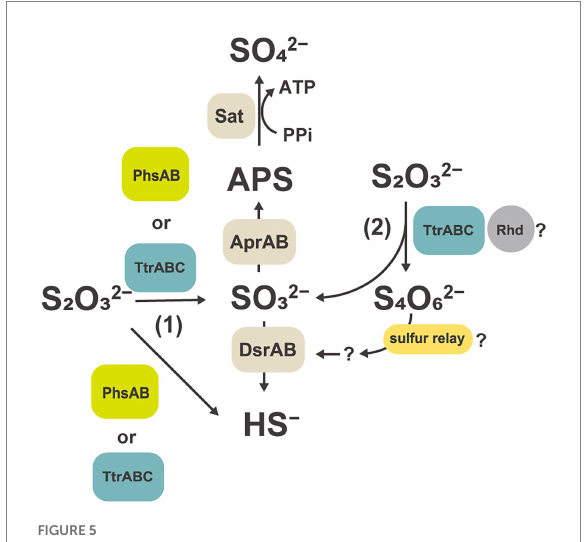
FIGURE 5 Hypothetical thiosulfate disproportionation pathways in strain GF1 T based on a comparative proteomic analysis. Sat, sulfate- adenylyltransferase; Apr, adenylyl-sulfate reductase; APS, adenosine 5 ′ -phosphosulfate; Dsr, dissimilatory sulfite reductase subunit; Phs, thiosulfate reductase-type protein; Ttr, tetrathionate reductase-type protein; Rhd, rhodanese-like domain-containing